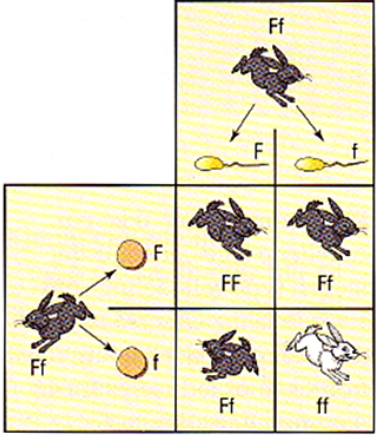
Figure 1. Punnett square diagram for two black-furred rabbits, as shown by the